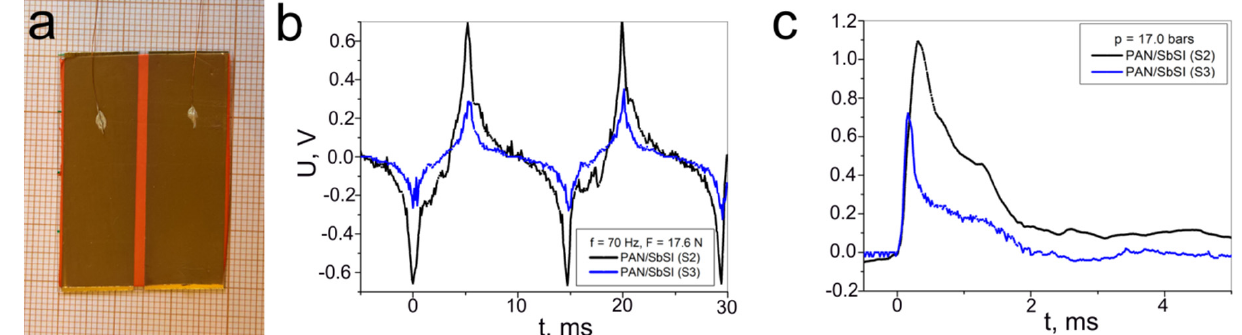
Figure 13. ( a ) Photograph of exemplary samples of the PAN/SbSI nanowires composites. ( b ) The output voltage from the PAN/SbSI samples over time, in which the black and blue lines relate to sample S2 and S3, respectively.These results are registered for ( b ) an impact with a force of 17.6 N at a frequency of 70 Hz and ( c ) a pressure of 17.0 bars.